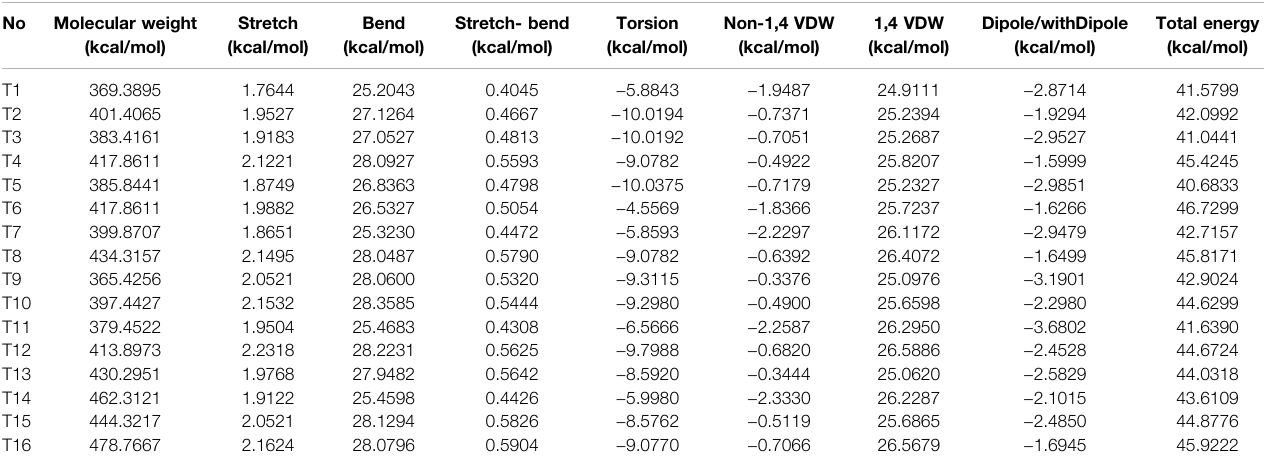
TABLE 1 | Molecular descriptors of the target compounds calculated via ChemBio 3D software. No Molecular weight (kcal/mol)